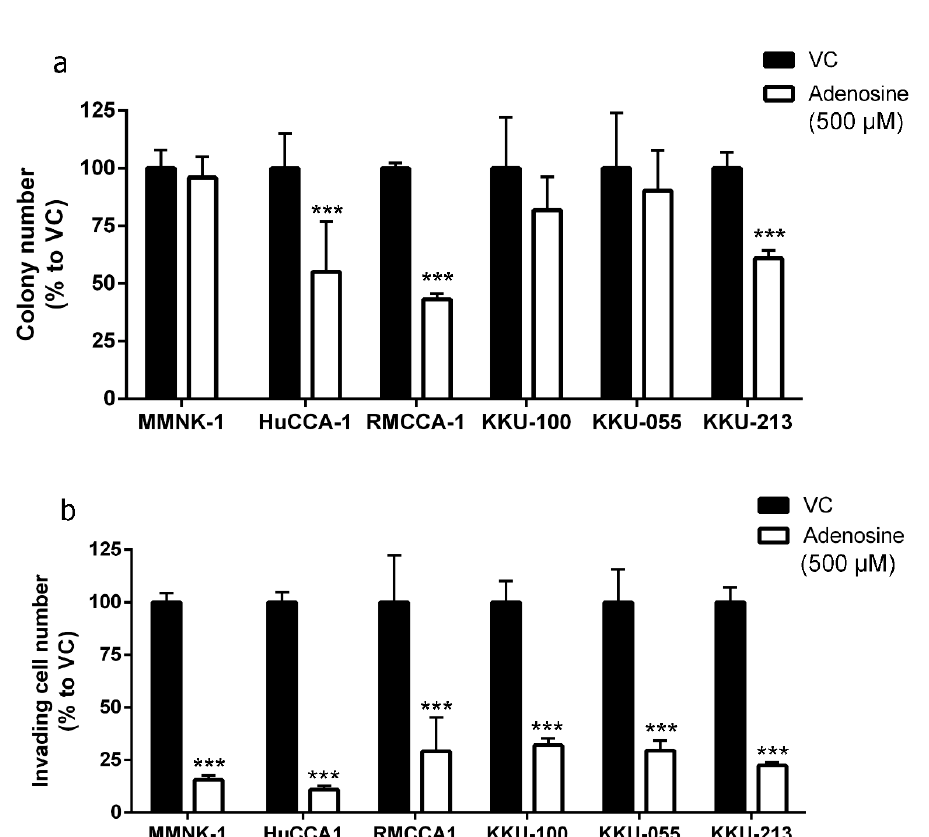
Figure 2. Adenosine inhibited cholangiocarcinoma (CCA) colony formation and cell invasion. ( a ) Adenosine reduced number of colony formation in adenosine-sensitive CCA cell lines after 2 weeks. ( b ) Adenosine significantly reduced number of invading cells through Matrigel in all cell lines tested, despite their sensitivity to adenosine in cell viability and colony formation assay. VC; vehicle control, *** p < 0.001. All experiments were performed using at least three biological replicates with internal triplicate. Graphs are plotted as mean ± SD.